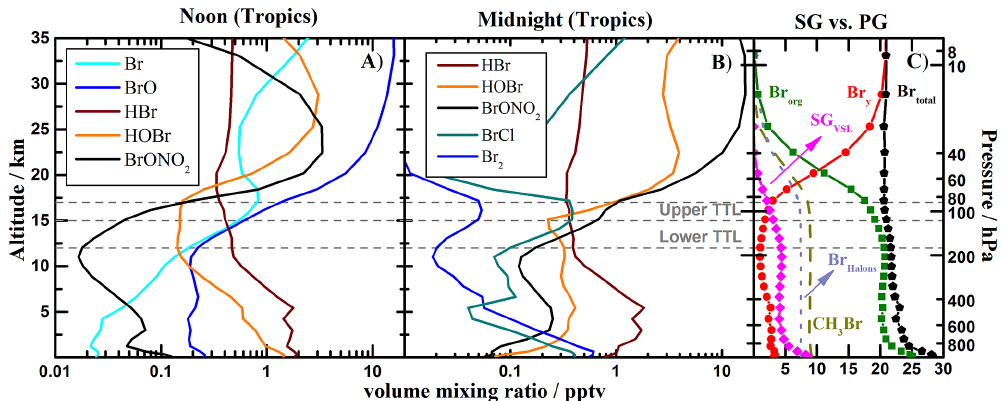
Figure 1. Annual vertical profile abundances of organic and inorganic bromine species within the tropics (20 ◦ N–20 ◦ S): (a) main Br y species at noon; (b) main Br y species at midnight; and (c) 24h average contribution of organic and inorganic species to total bromine. The horizontal dotted lines represent the approximate location of the TTL.